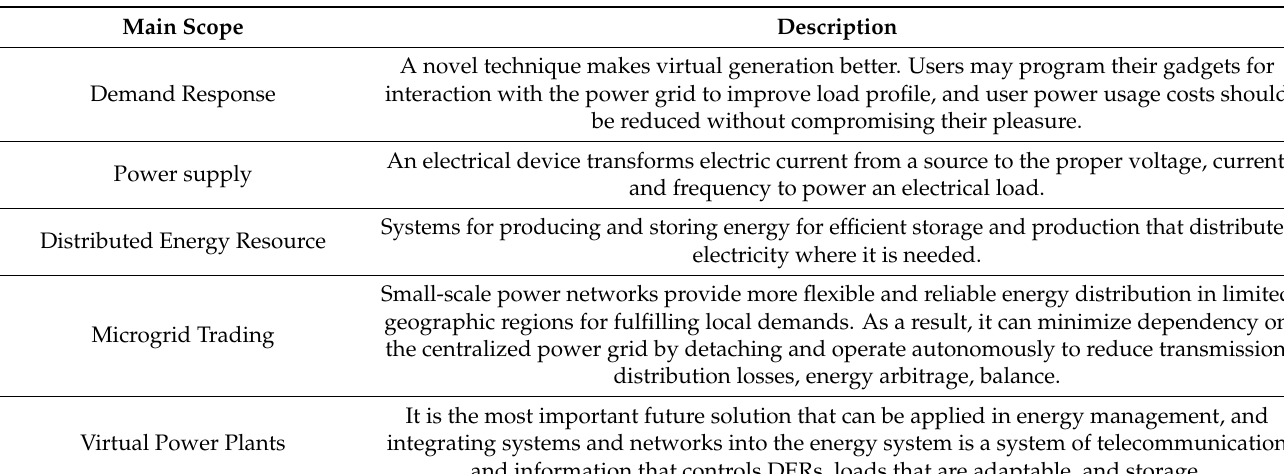
Table 3. Main scope of the smart grids